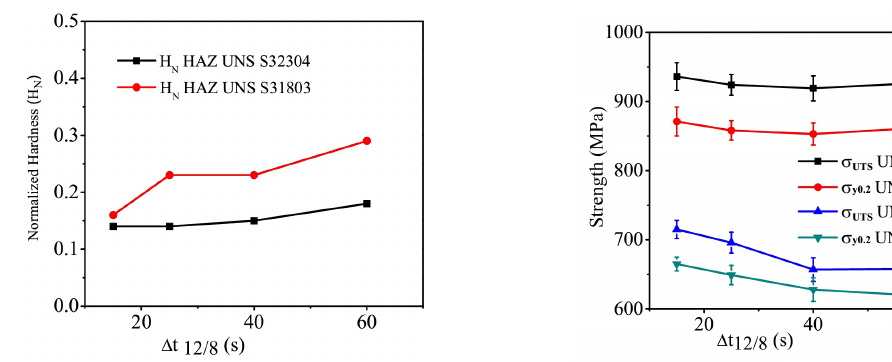
Figure 8. The experimental ultimate tensile strength (σ yield strength (σ ) values corresponding to the simulated HAZs at y0.2 different cooling times of the UNS S31803 and UNS S32304